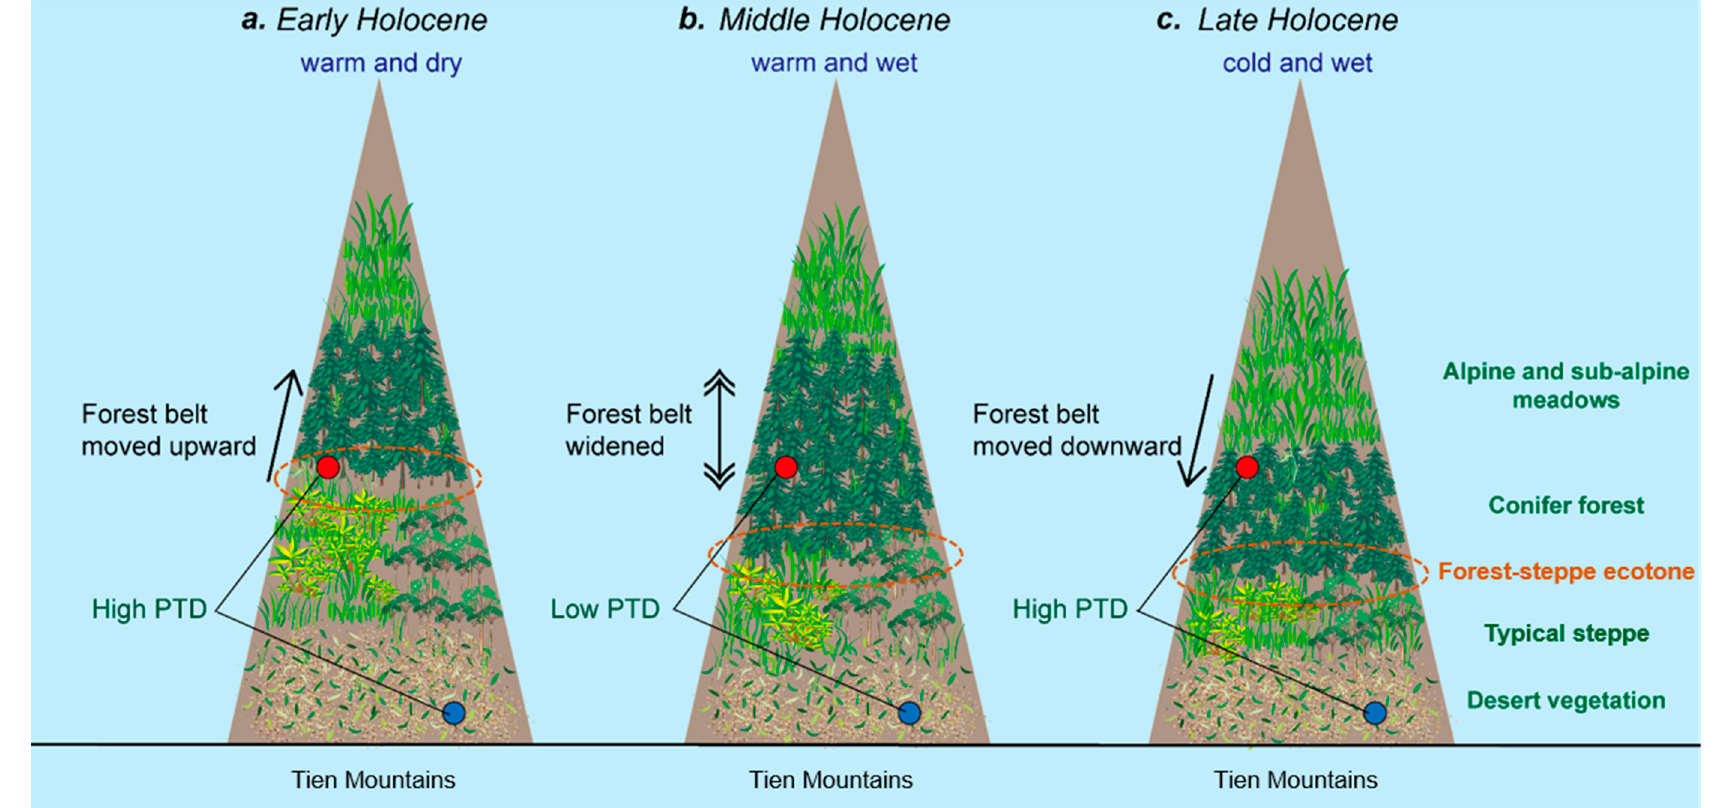
Figure 6 . Schematic diagram presenting changes in pollen taxa diversity (PTD) and the migration of the forest-steppe ecotone under the Holocene’s changing climate ( a – c ). In the belt of the typical steppe, the steppe is mainly distributed on the sunny slope, while the forest is distributed on the shady slope. The red dot represents the location of Sayram Lake, while the blue dot indicates the location of Aibi Lake. The orange ellipse indicates the possible range of the forest-steppe ecotone.